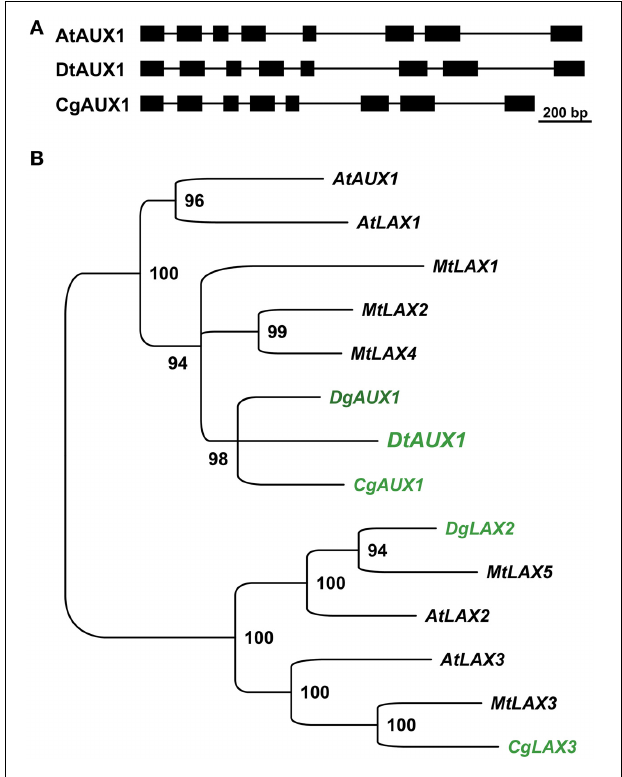
FIGURE 4 | DtAux1 encodes a putative orthologue of CgAUX1 / AtAUX1 . (A) Exon-intron structure of DtAUX1 compared to AtAUX1 and CgAUX1 . Exons are displayed as black boxes. (B) Maximum likelihood phylogeny obtained with the coding sequences of AUX - LAX genes. DtAUX1 clusters together with CgAUX1 and DgAUX1 and belongs to the AUX/LAX subclass of auxin influx carriers. Numbers indicate the percentage of bootstrap